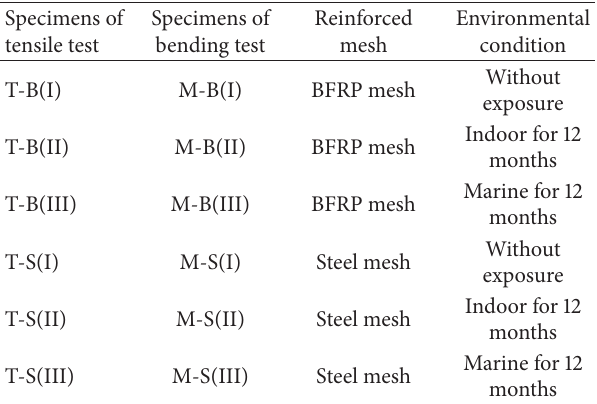
Figure 1: Molds of thin plates. Table 1: Details of